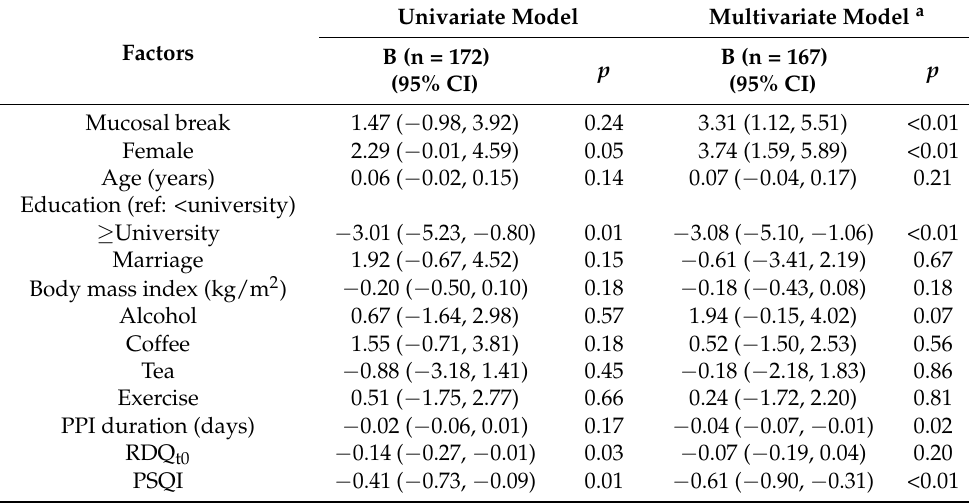
Table 3. Multivariate linear regression models to examine the factors associated with the change in the Taiwanese Depression Questionnaire score.